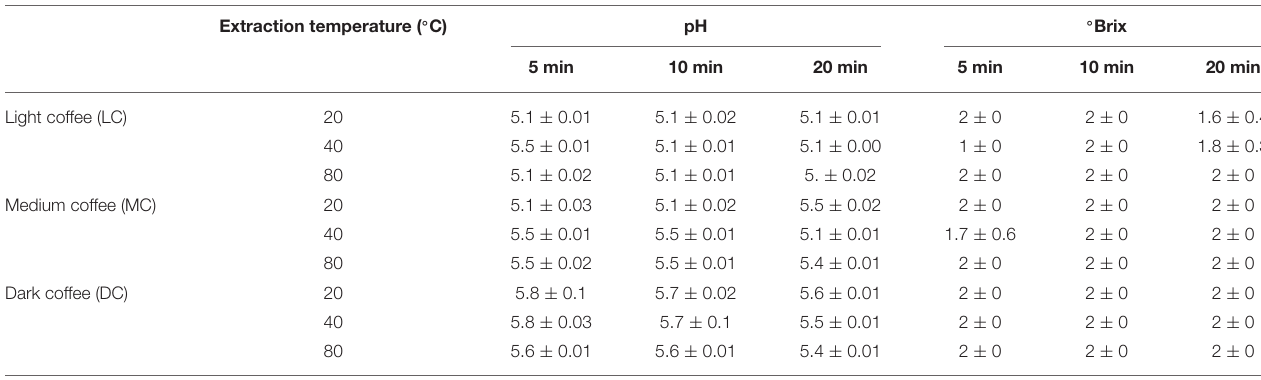
TABLE 2 | pH and ◦ Brix of coffee roast extracts according to extraction temperature and